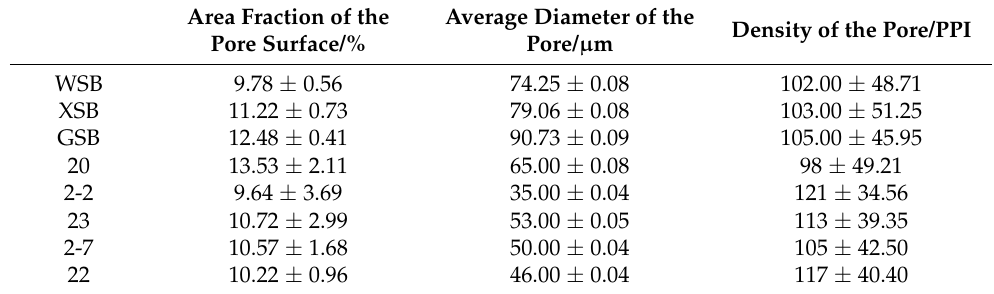
Figure 3. Image of stomatal structure of steamed bread core of different sourdough steamed bread (( a ): 2D plane scan; ( b ): analytical graph after gray treatment; ( c ): 2D plane scan; ( d ): analytical graph after gray treatment). Table 2. Image analysis of steamed bread.